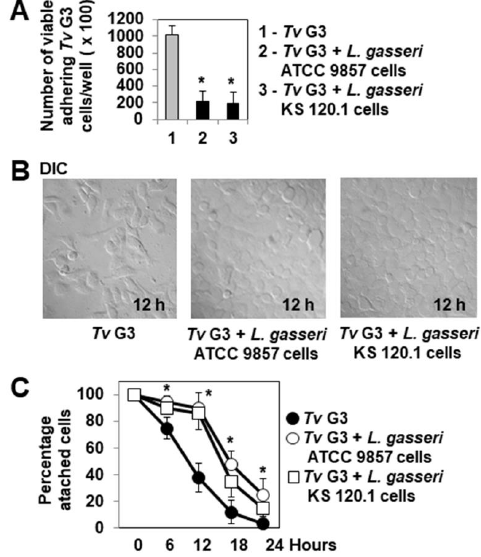
Figure 2. The prior adhesion of L. gasseri to cells delays Tv G3-induced cell detachment. ( A ) Levels of parasites adhering to HeLa cells with and without prior colonization with L. gasseri ATCC 9857 or KS 120.1 cells. In ( B ), representative differential interference contrast micrographs of cells. In ( C ), progression of cell detachment over time for cells with and without prior colonization with L. gasseri ATCC 9857 or KS 120.1 cells. The micrographs shown are representative of two independent experiments. Each value shown is the mean ± SD of three separate experiments. In ( A , C ), * p < 0.01 for comparisons with Tv G3.